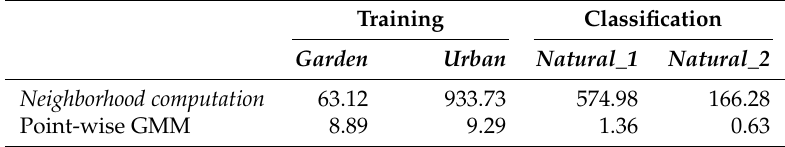
Table 7. Computation times for point-wise neighborhood training and classification, in